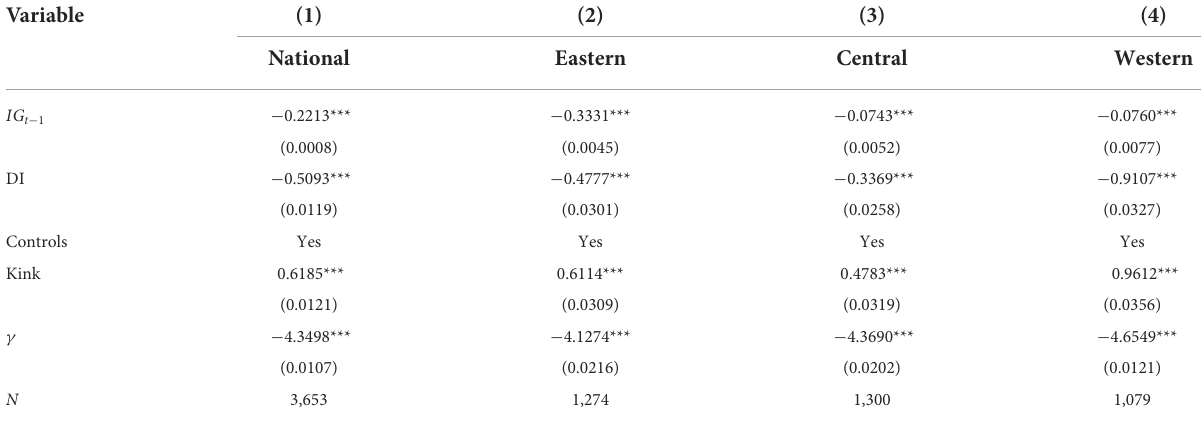
TABLE 3 Dynamic effect